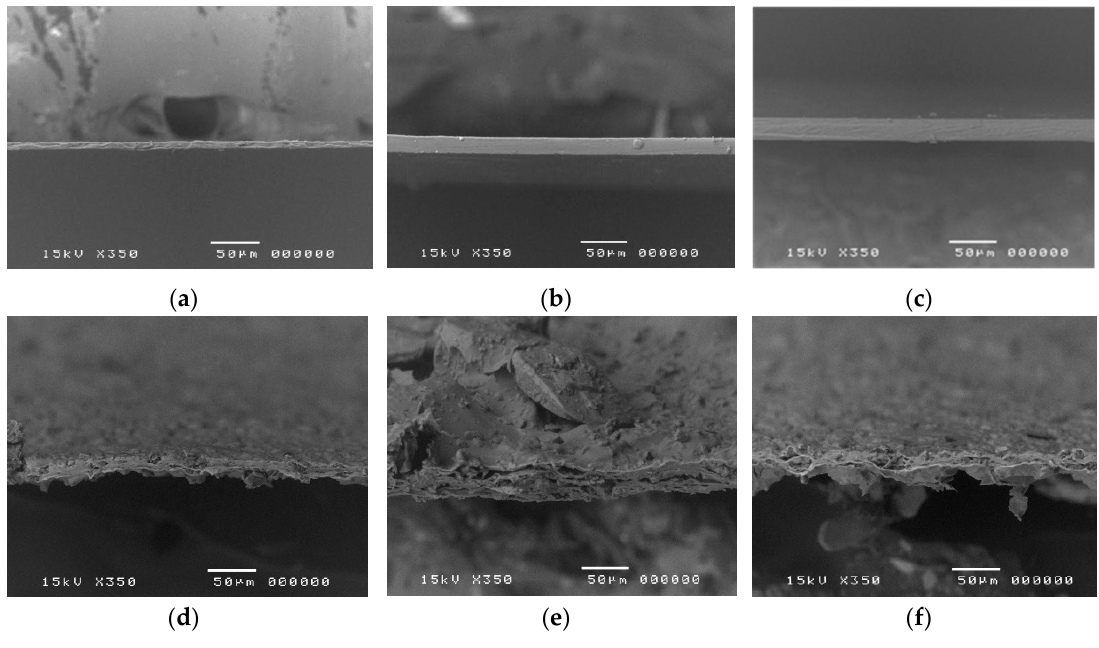
Figure 1. Scanning electron microscopy of the thickness at 350 × magnifications of non-plasticized ( a ) 40% Gly-plasticized ( b ) and 40% PG-plasticized ( c ) LMP films and those films loaded indomethacin ( d ), ( e ) and ( f ), respectively. Gly: Glycerol; PG: Propylene glycol; LMP: Low-methoxyl